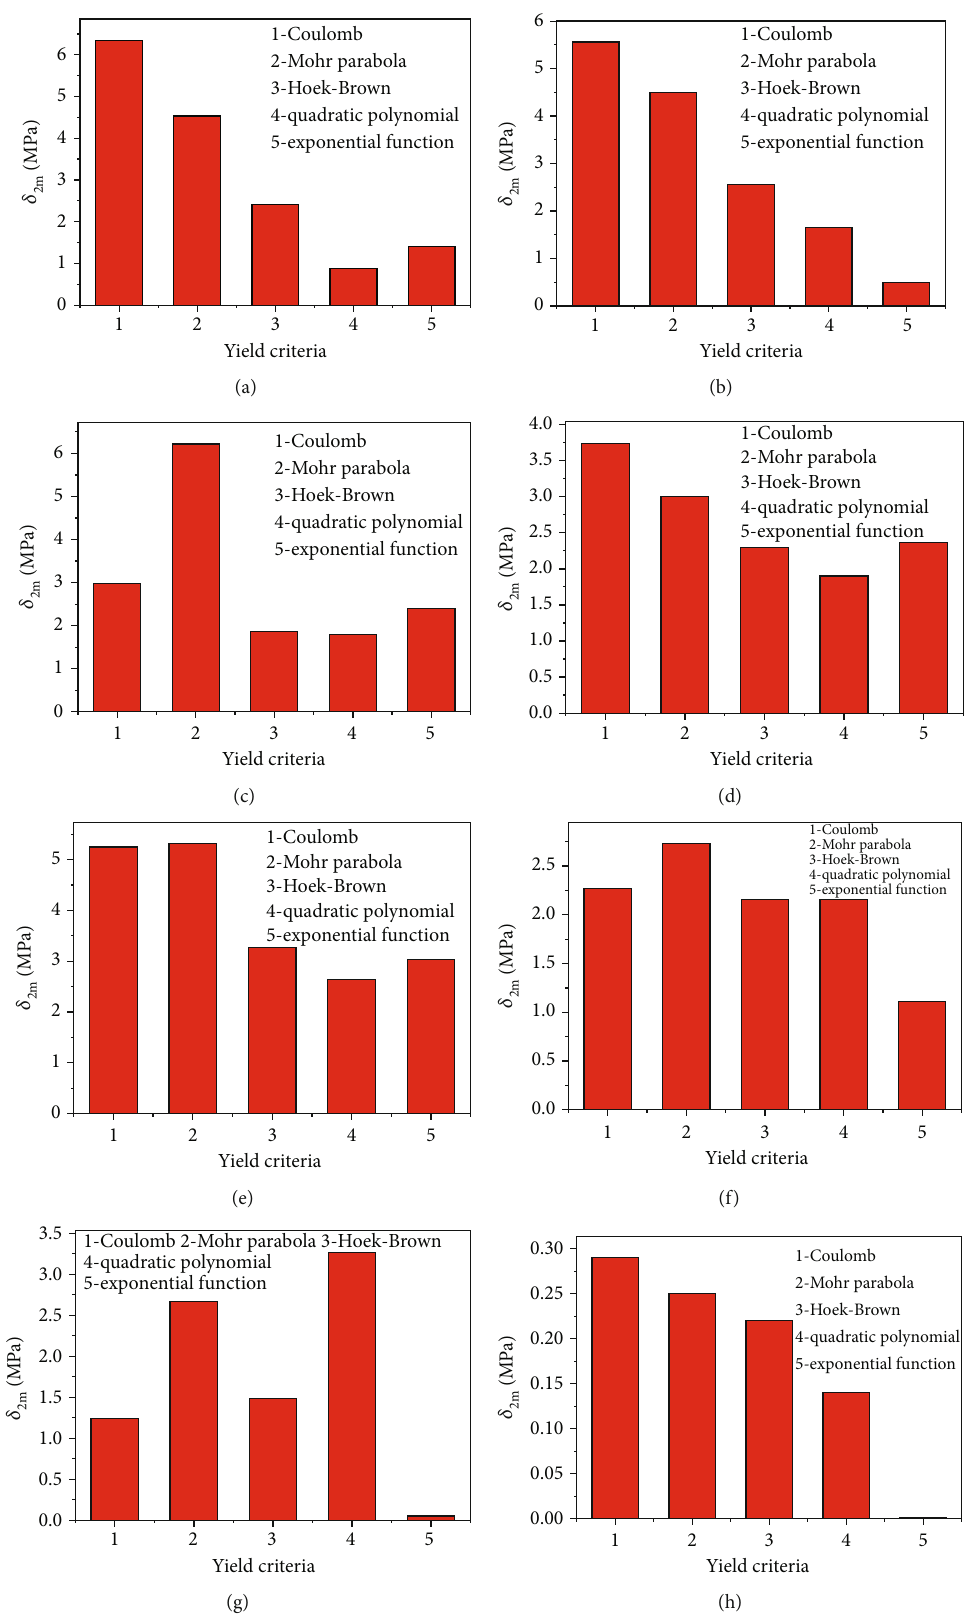
Figure 3: Mean fi tting deviations of fi ve yield criteria. (a) DT Natural coal. (b) BD Natural coal. (c) XH Natural coal. (d) YC Natural coal. (e) DT Water-saturated coal.(f) DT Seepage coal. (g) BD Seepage coal. (h) XH Seepage